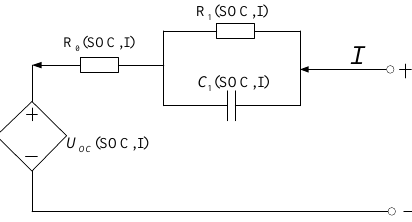
Figure 1. First-order circuit model of battery.